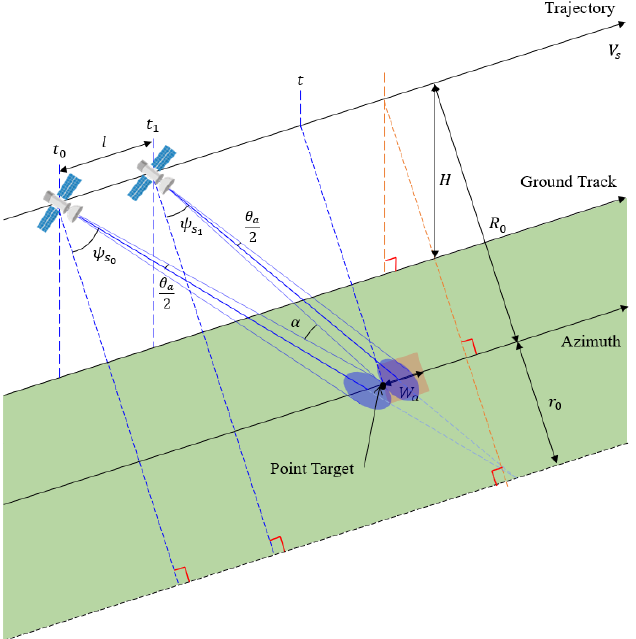
Figure 8. Image-taking geometry of a point target within target scene for the squint sliding spotlight mode.